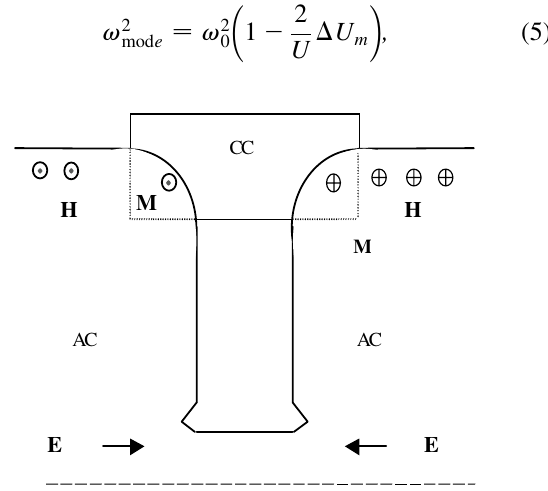
FIG. 1. Diagram for two coupled cavities in the (cid:3)= 2